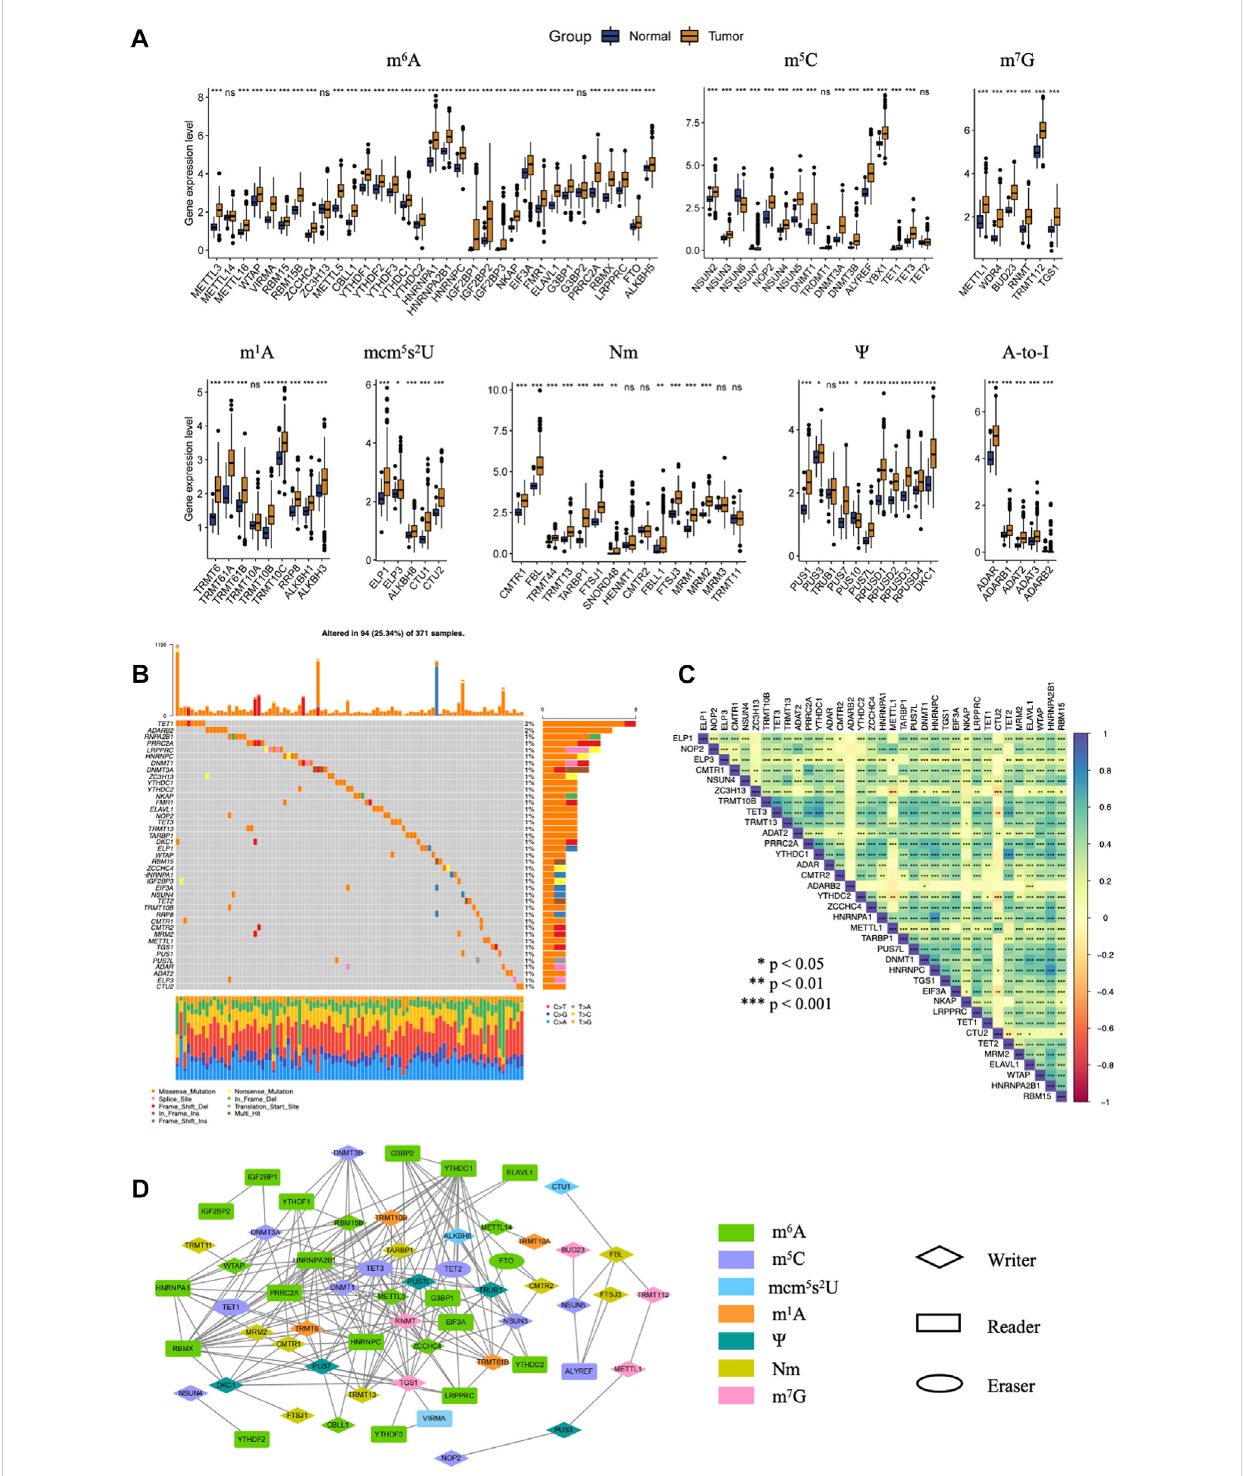
FIGURE 1 The dysregulation and mutation landscape of 100 RNA modi fi cation regulators included in our study in HCC. (A) The gene expression level of 100 RNA modi fi cation regulators in normal and tumor tissues in TCGA-LIHC. (B) Genomic mutational landscape of RNA modi fi cation regulators with mutation rates ≥ 1% in the TCGA-LIHC cohort. (C) Correlation of the mutation between genes with mutation rates ≥ 1%. (D) The protein-protein interactions between one hundred RNA regulators analyzed by the STRING database. ( p -value < 0.05 and correlation coef fi cient ≥ 0.6). (ns, not signi fi cant; *, p < 0.05: **, p < 0.01; ***, p <